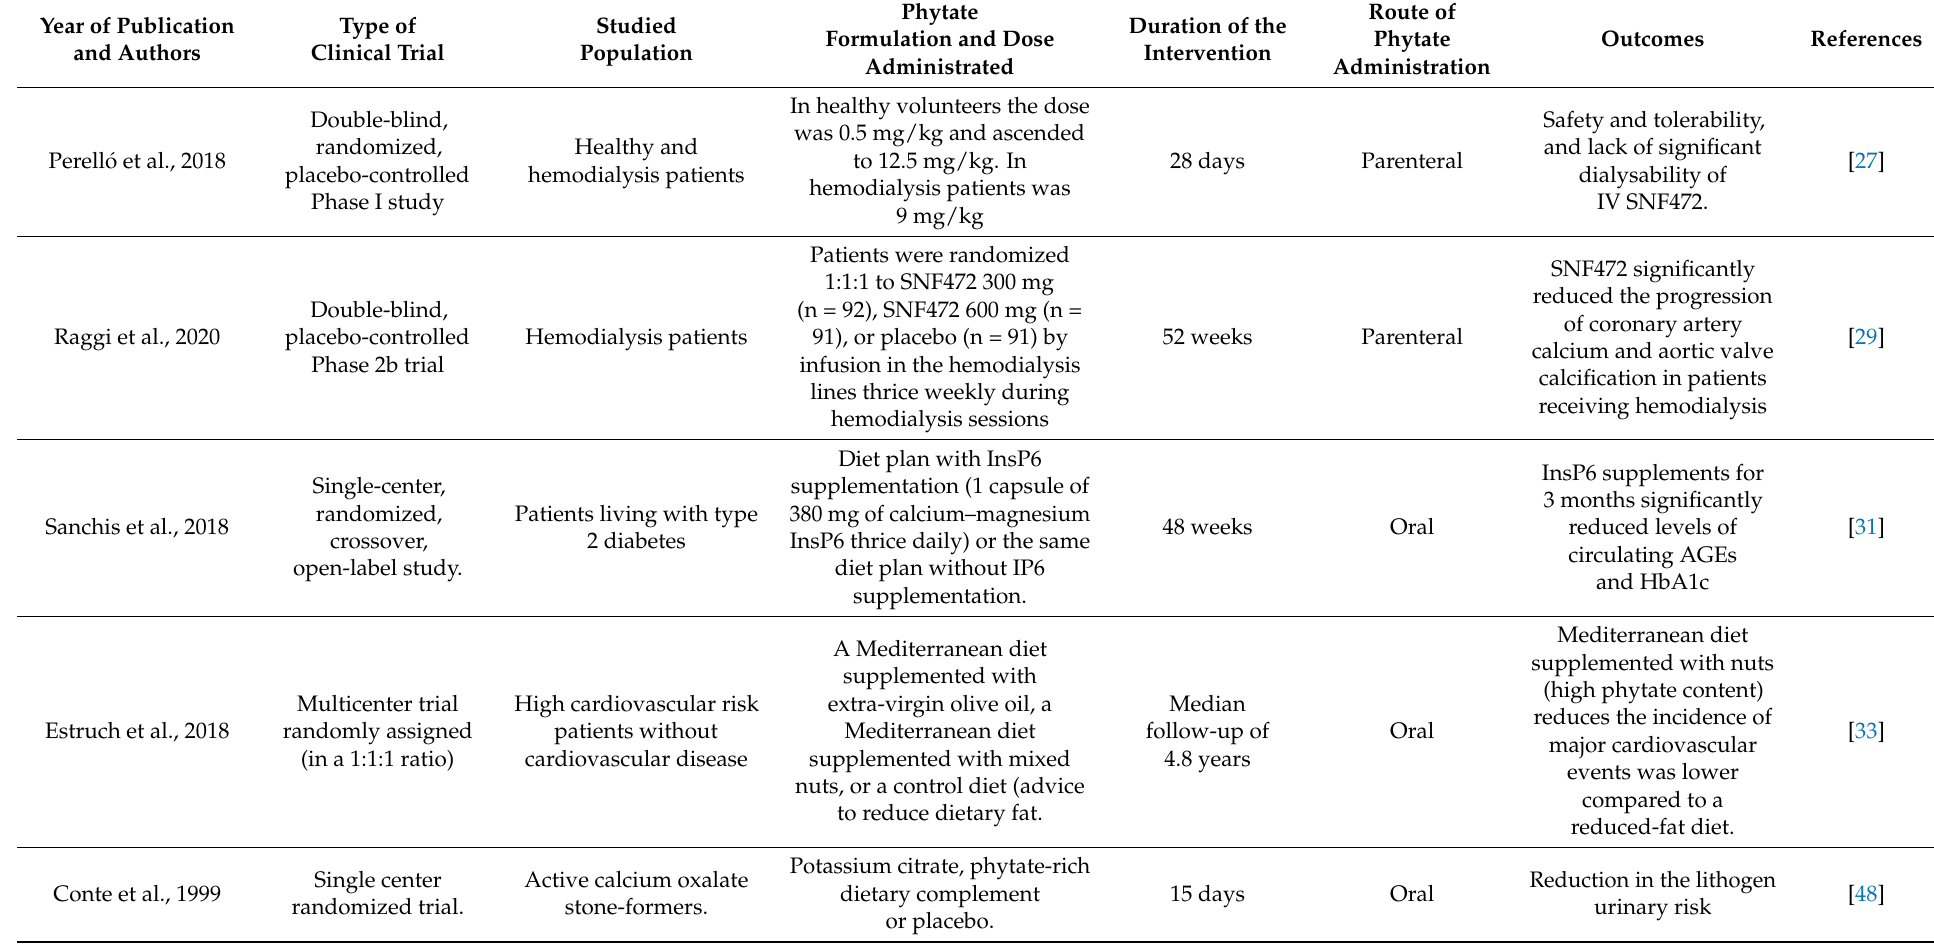
Table 1. Clinical trials in humans using